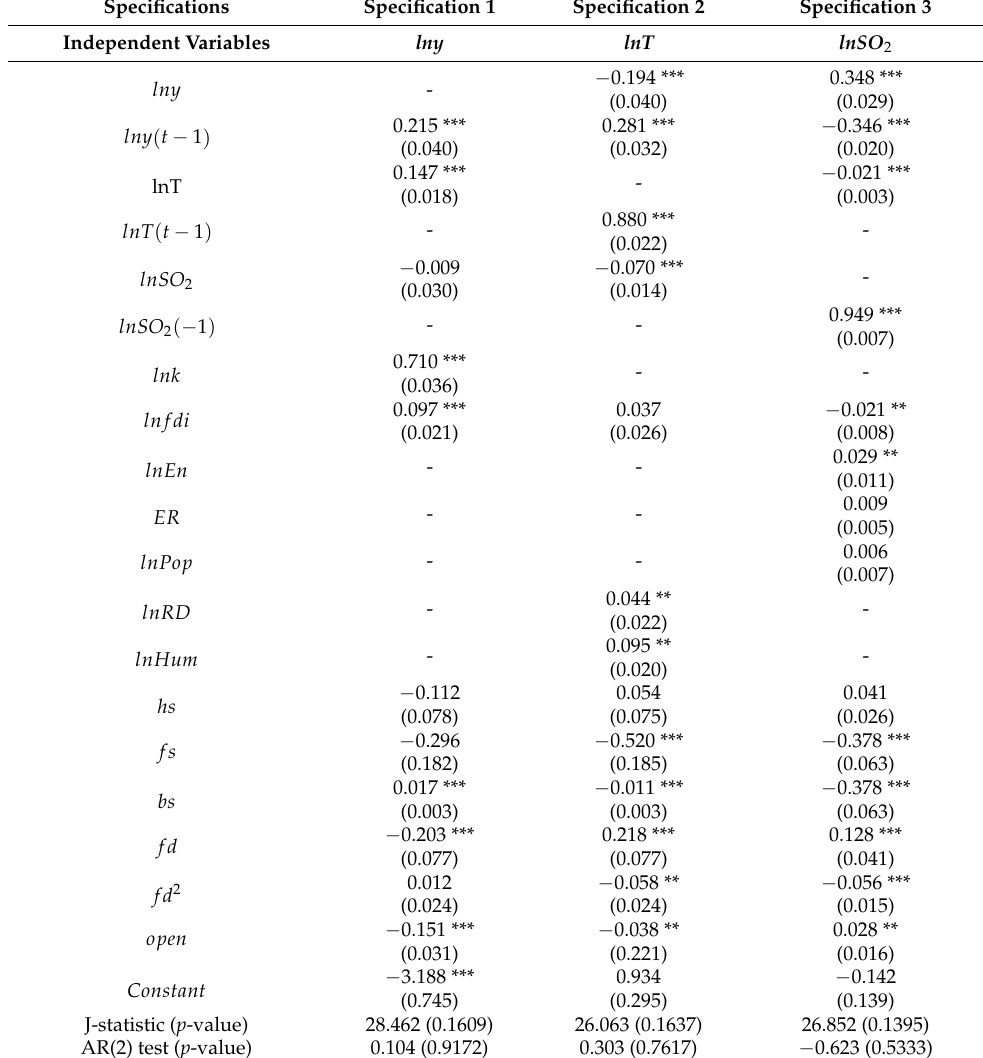
Table 4. GMM estimation results of panel simultaneous equations of Equations (11)–(13) ( R represents SO 2